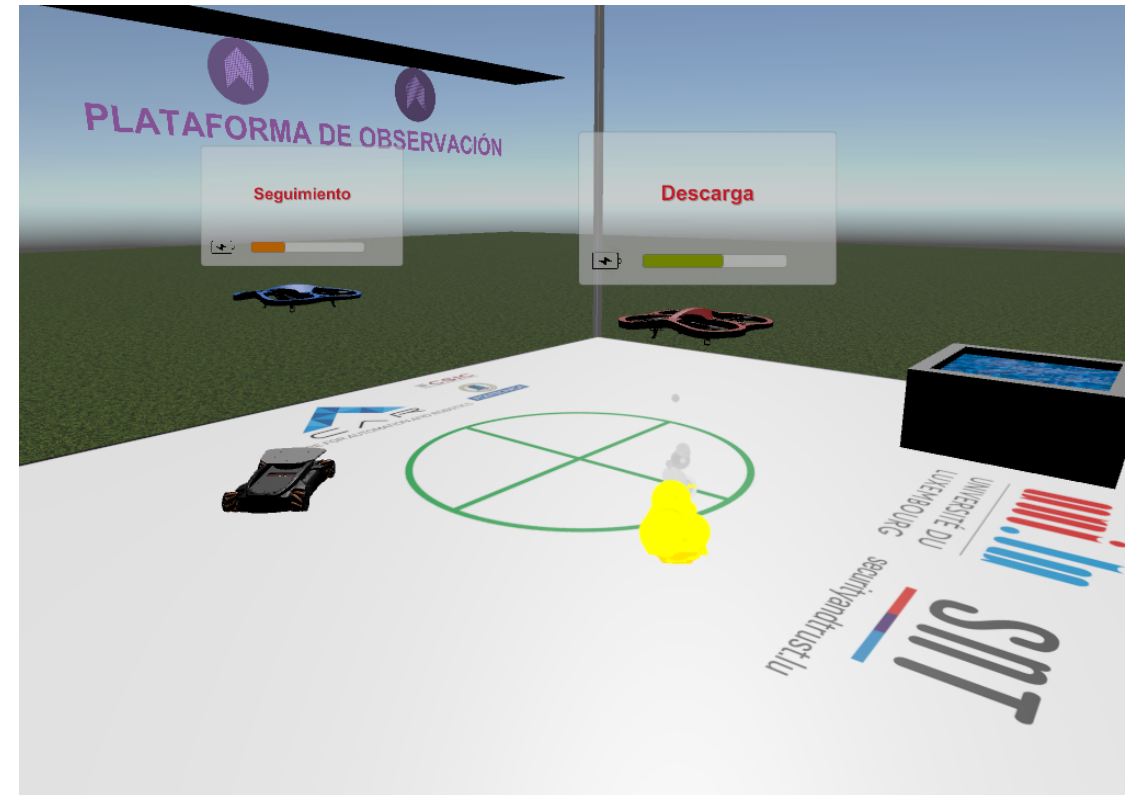
Figure 9. Non-predictive virtual reality interface.